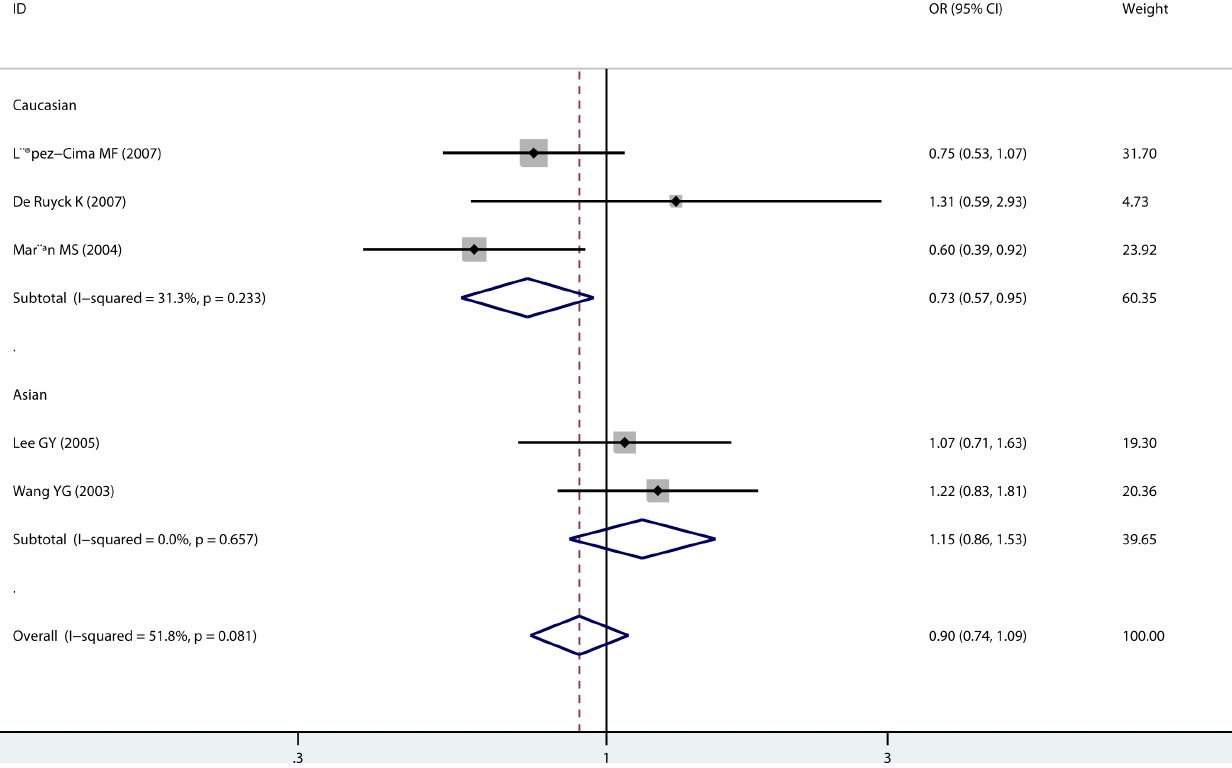
Figure S3 Funnel plot of XPC PAT polymorphism. Circles represent the weight of each study.